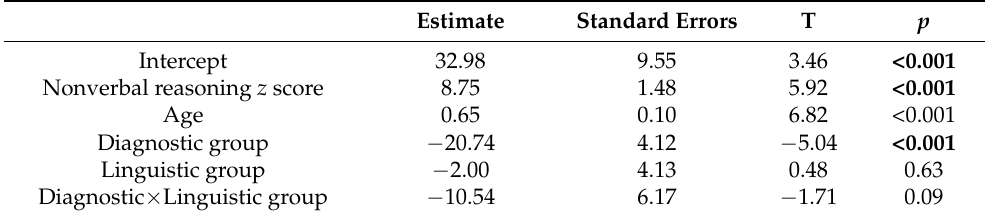
Table 4. Linear regression of total DA score using age, nonverbal reasoning z score, and diagnostic and linguistic groups and the interaction of these two as independent